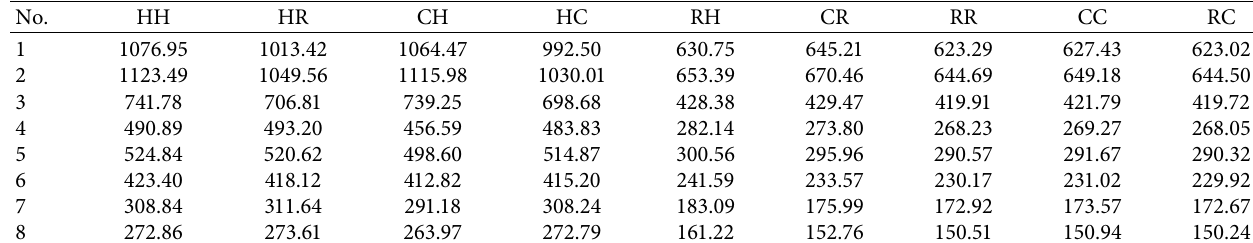
Table 4: Mean makespans of schedules returned by the LS algorithms for the SCP1 benchmark with cov � 80%. Codes in column headers: C: CAIA, H: HMA, R: RFTA; e.g., HR represents the version [HMA, RFTA]. No.